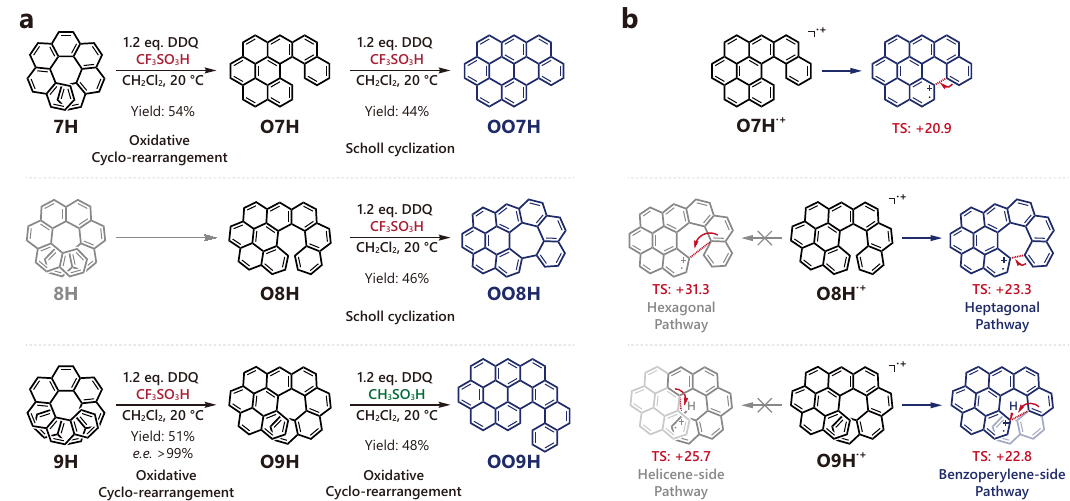
Fig. 3 Stepwise oxidations of 7H, 8H, and 9H. a Two-step oxidation of 7H , 8H , and 9H . b Possible cyclization processes following a radical cation mechanism and their activation energies (free energies of the corresponding transition states, TS, in kcal mol − 1 ). The free energies of the radical cation intermediates O7H · + , O8H · + , O9H · + are set as